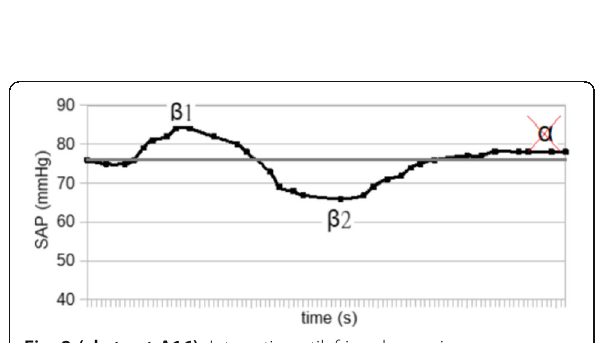
Fig. 6 (abstract A16). See text for description